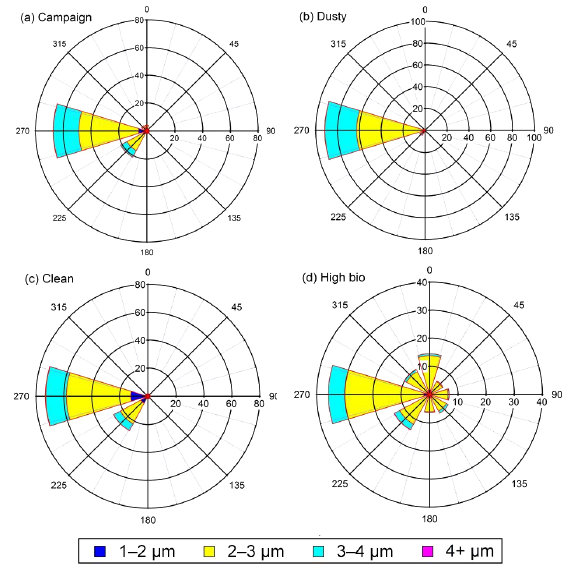
Figure 14. Wind rose diagram scaled by wind speed and the geo- metric mean diameter ( D g ) of d N F / dlog D a . The figures have been separated for the FBAP number concentration ( N F ) range, N F >0.1 and N F <0.1cm − 3 observed during the high bio period. For exam- ple, when N F >0.1cm − 3 ∼ 60% of the time wind was observed to be in the range of 0–1ms − 1 (a) and ∼ 94% of the time, the ge- ometric mean diameter ( D g ) of d N F / dlog D a was in the range of 2–3µm (c) . On the other hand, for N F <0.1cm − 3 ∼ 60% of the time, wind speed was greater than 1ms − 1 (b) , and ∼ 80% of the time the geometric mean diameter ( D g ) of d N F / dlog D a was in the range of 2–3µm (d)